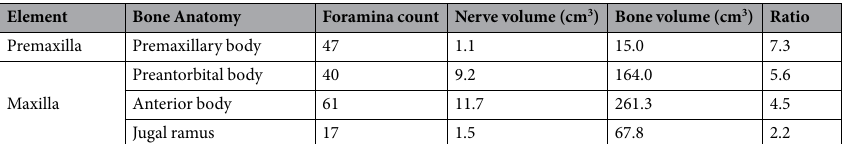
Table 1. Foramina count, neurovascular volume, bone volume, and ratio (%) in the premaxilla and maxilla of Neovenator